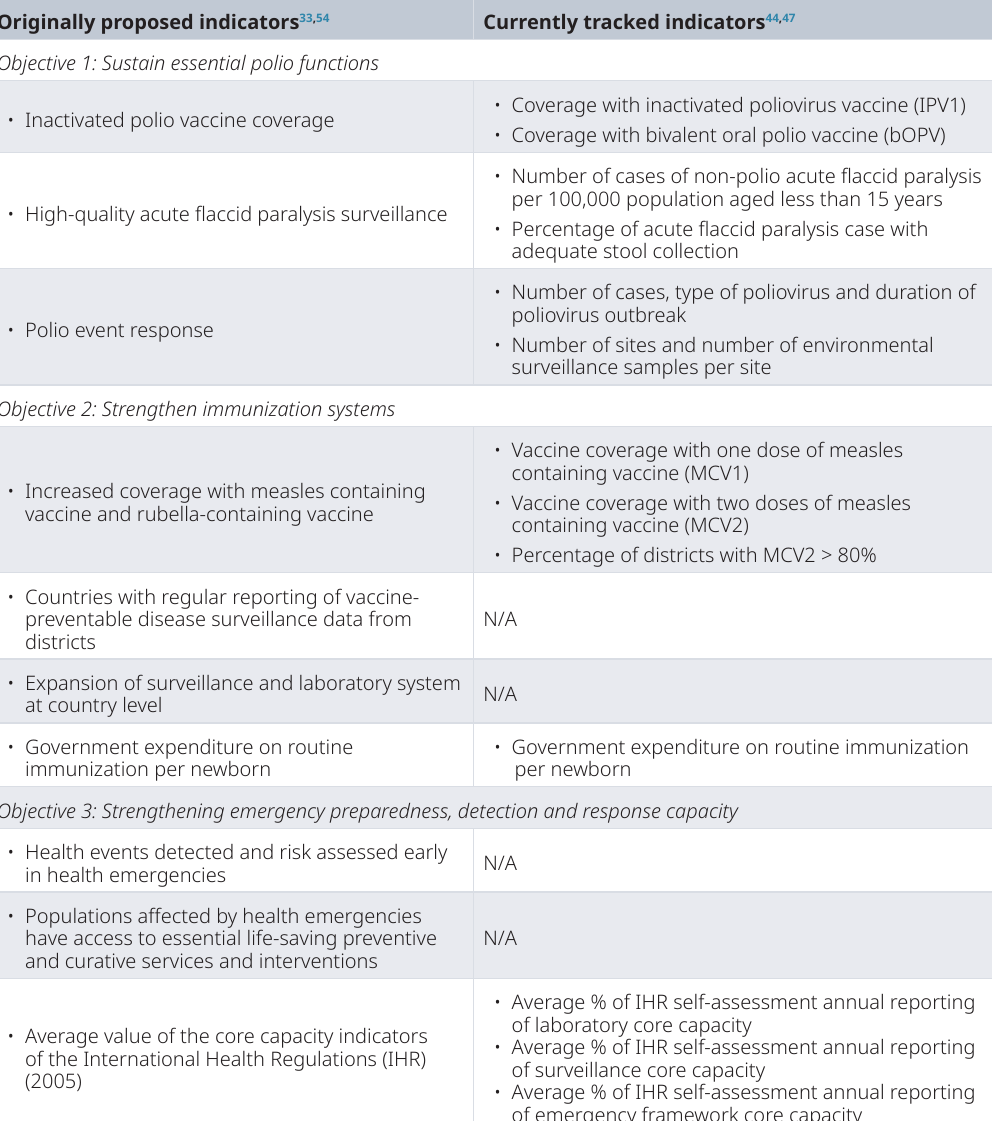
Table 1. WHO objectives and indicators related to the use of polio assets for polio-specific (objective 1) and non-polio-specific (objectives 2 and 3) activities as originally defined in Strategic Action Plan on Polio Transition (see references indicated in the table for the operational definition of each